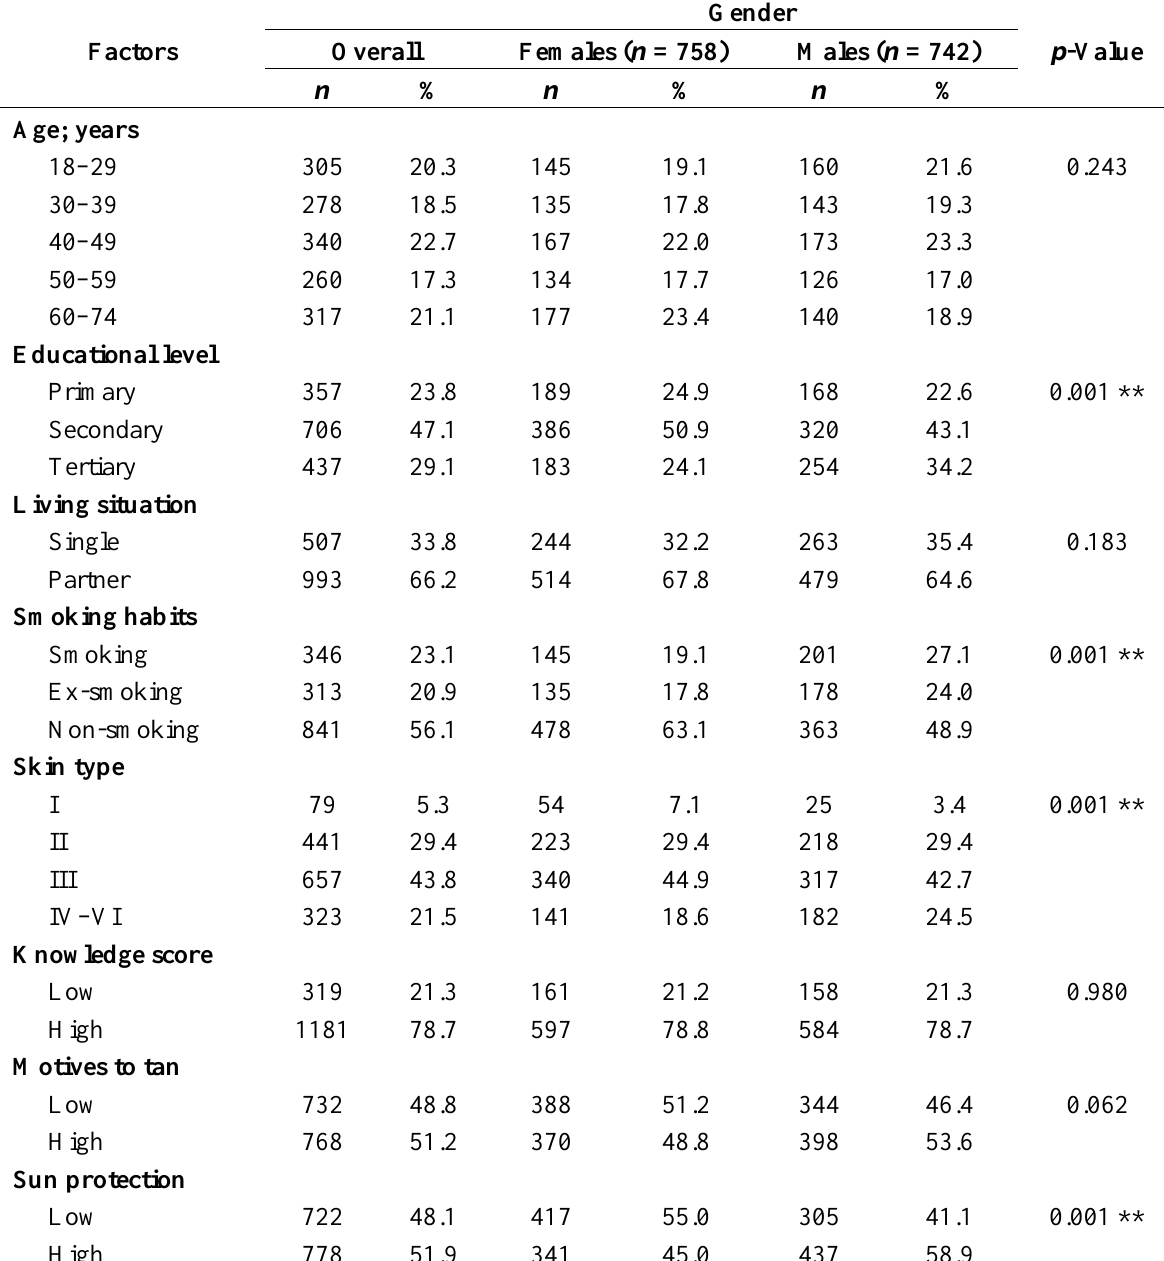
Table 1. Basic characteristics of study population, stratified by